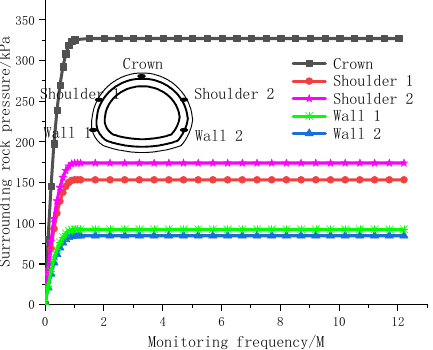
Figure 14. Monitoring values for confining pressures in deeply buried tunnel.